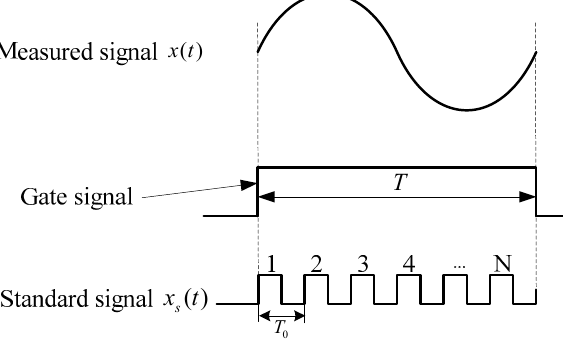
Figure 1. Schematic diagram of frequency measurement based on period method.